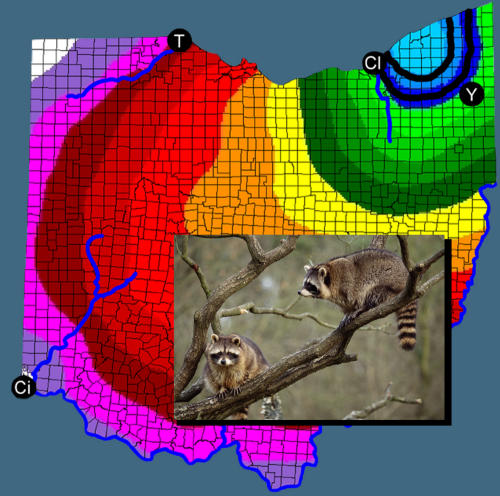
Predicting the spread of raccoon rabies across Ohio